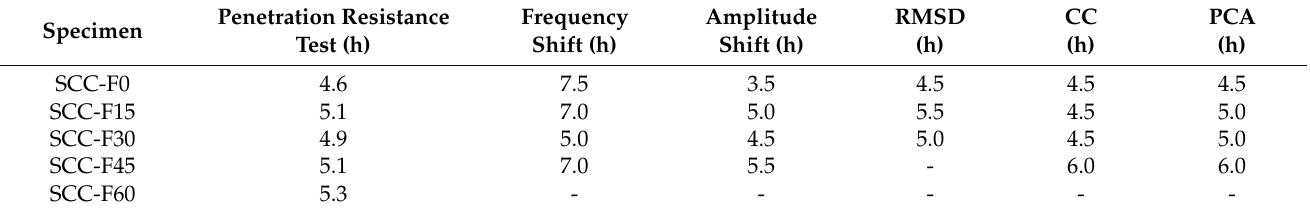
Figure 10. Comparison of the initial and final setting times for SCC specimens tested by different techniques. Table 5. Time gaps between the initial and final settings by different approaches.